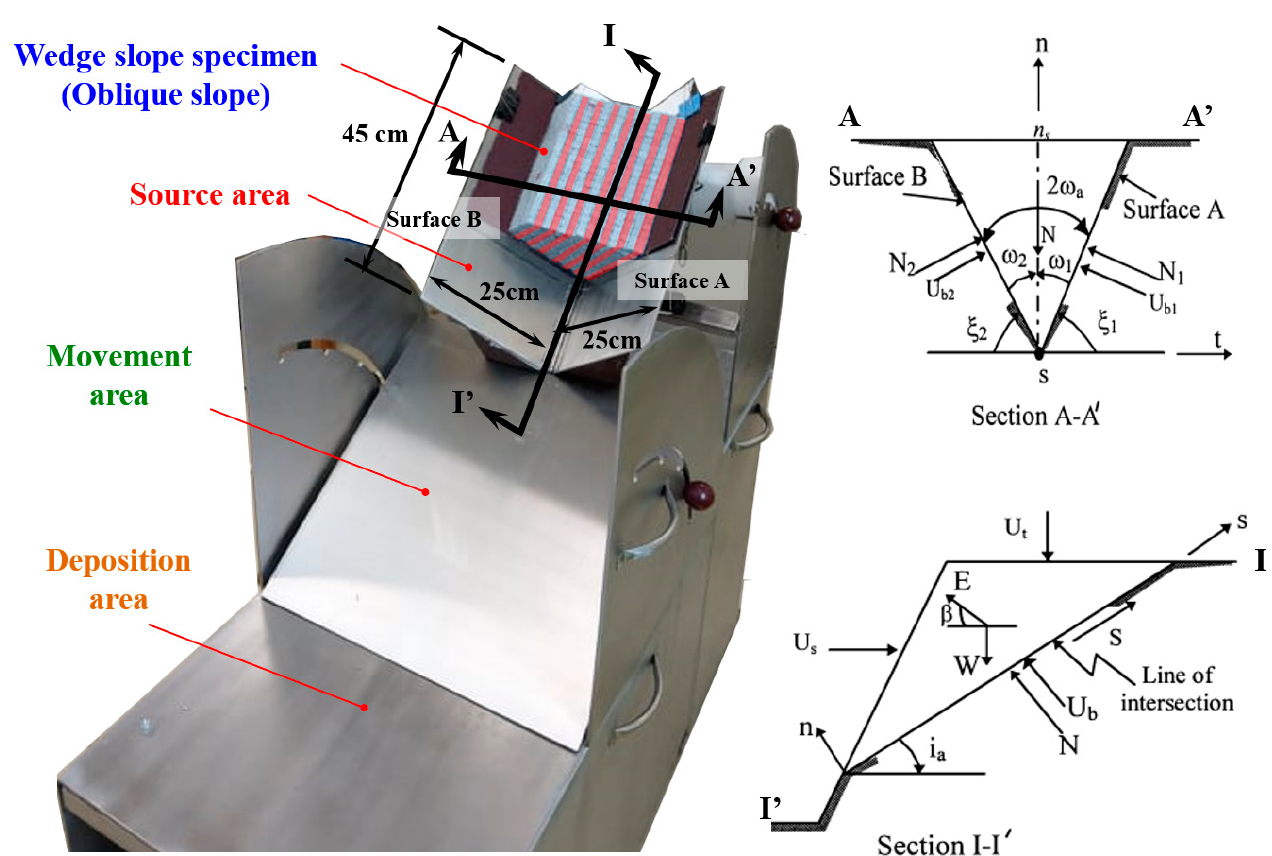
Figure 4. Setup of the physical model.